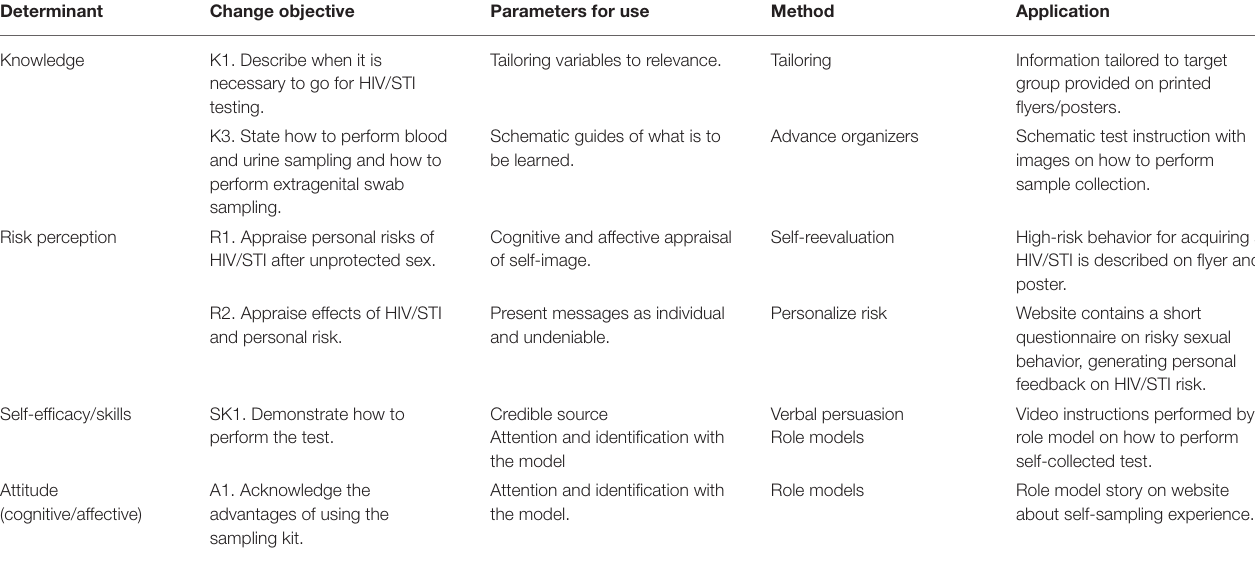
TABLE 2 | Examples of selected theoretical methods and applications used to get men who have sex with men (MSM) tested for HIV/STIs.